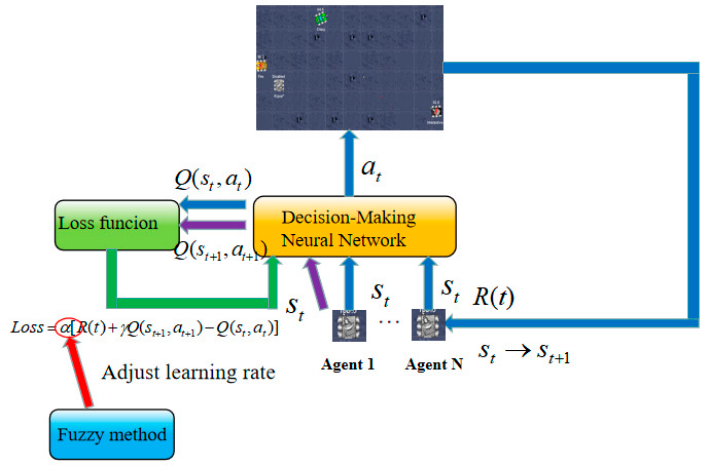
Figure 6. Framework for the proposed method for micromanagement.